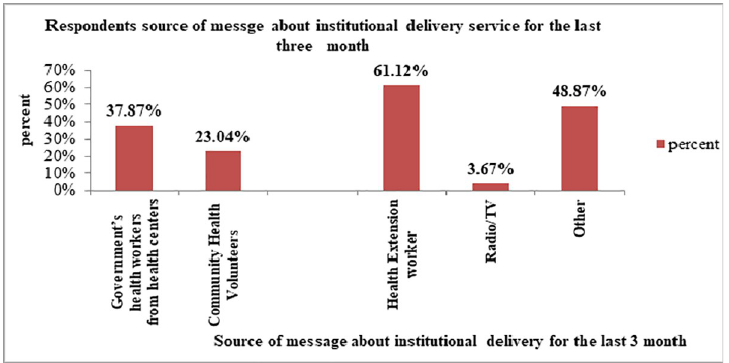
Fig 1. Respondents source of message about institutional delivery for the last 3 month, Central Gondar zone, North West Ethiopia, 2020. Legends � other (school adolescent, NGO staff, church/mosque, poster/flyer/leaflet, community event, community discussion, family discussion, clinic/hospital, traditional